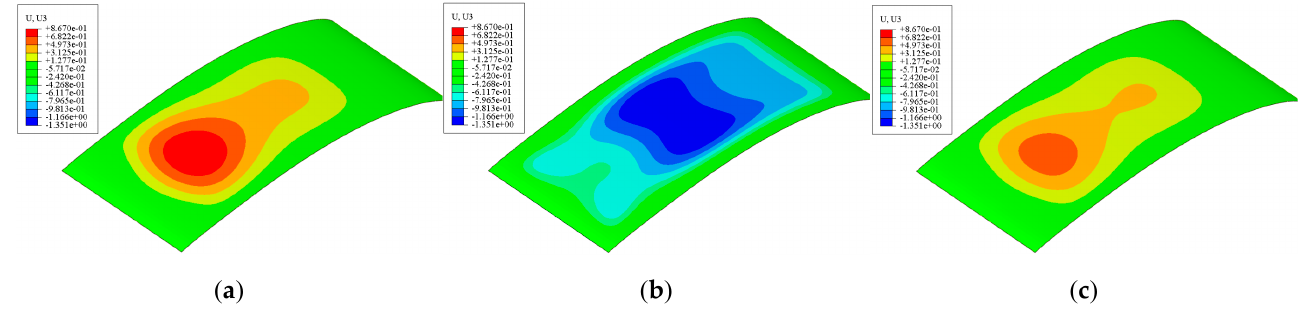
Figure 27. Upper surface deformation under different prestress: ( a ) P s = 0.017 MPa, P c = 0.017 Mpa; ( b ) P s = 0.017 MPa, P c = 0.051 Mpa; ( c ) P s = 0.051 MPa, P c = 0.017 Mpa.